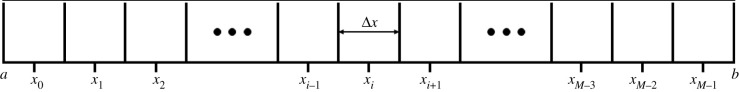
Schematic illustrating a spatial discretization of the one-dimensional domain [a, b], which is used to simulate equation (2.2) numerically. Δx represents the size of the voxels and xi for i = 0, …, M − 1 represent their centres.